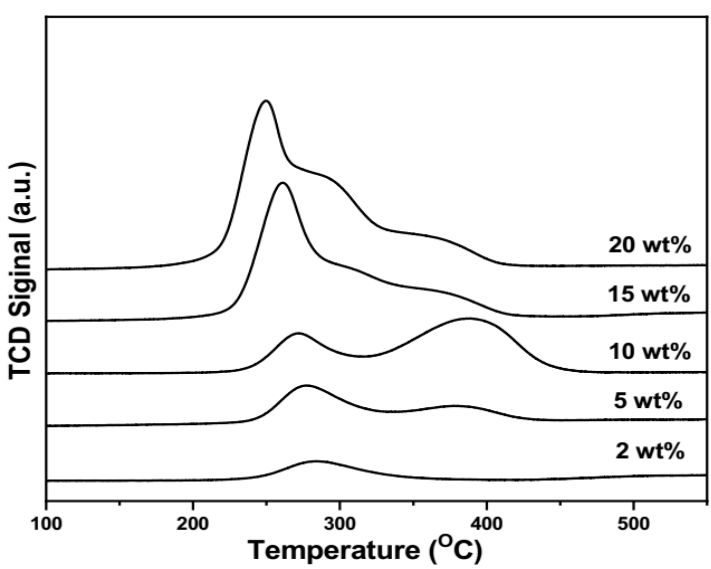
Figure 3. H 2 -TPR profiles of various Cu/SiO 2 catalysts. Table 2. H 2 consumption and reaction temperature of the various Cu/SiO 2 Catalysts from H 2 -TPR profiles.